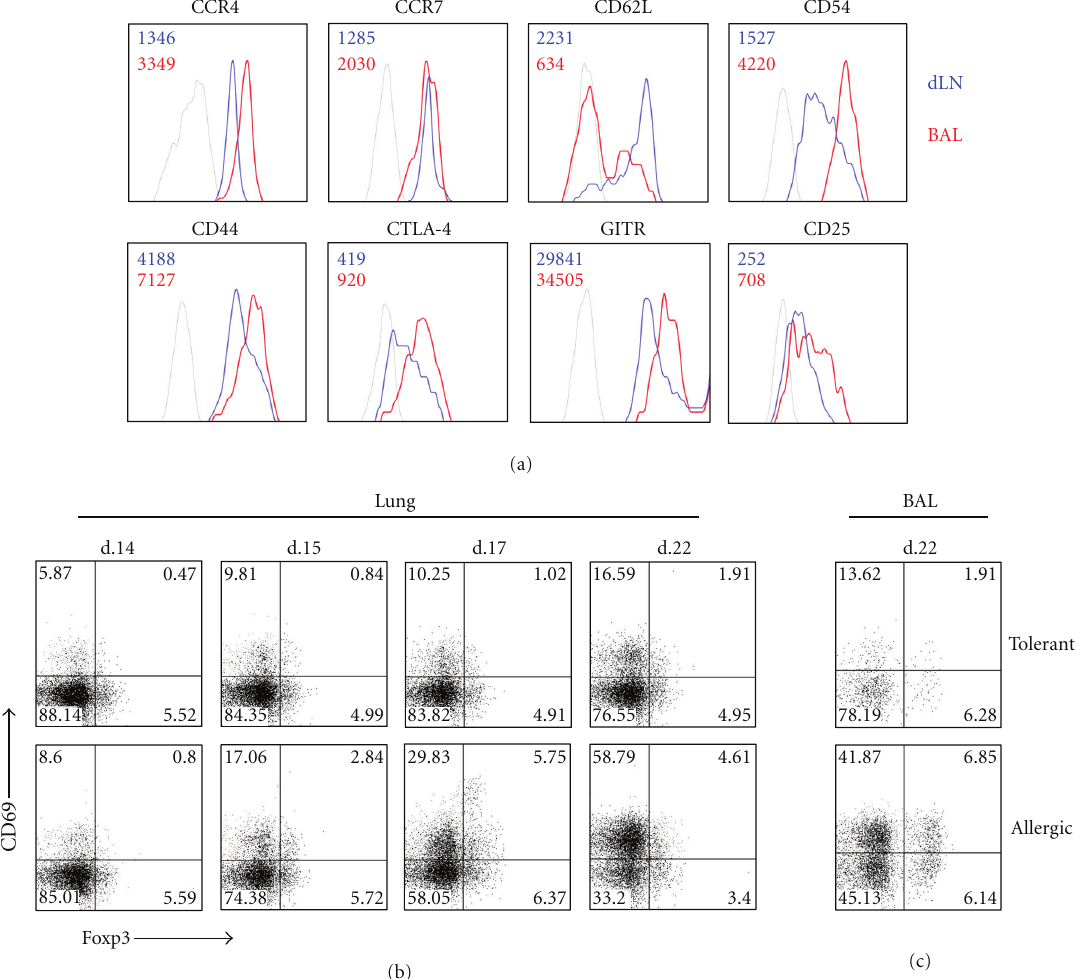
Figure 4: Airway regulatory T cells from allergic mice express a memory/e ff ector phenotype. (a) FACS-Histograms of CD4 + Foxp3 + cells from allergic mice expressing CCR4, CCR7, CD62L, CD54, CD44, CTLA-4, GITR, CD25 in BAL (red line), or mediastinal draining lymph nodes (dLN) (blue line). The numbers into each histogram represent the mean fluorescence intensity (MFI). Kinetic of lung CD4 + CD69 + cells frequency expressing or not Foxp3. (c) Percentage of BAL CD4 + CD69 + cells expressing or not Foxp3. Pooled cells from four mice recovered from lung or BAL were stained for CD4, CD69, and Foxp3 and gated in CD4-positive cells. The results are representative of two experiments with four mice per